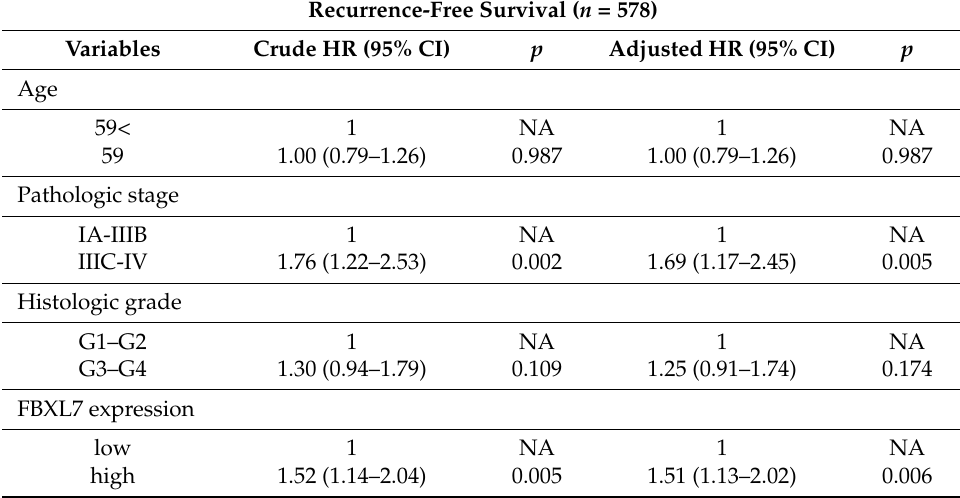
Table 1. Cox univariate and multivariate analyses under the condition of recurrence-free survival probability in association with FBXL7 mRNA expression levels and pathological stage derived TCGA (The Cancer Genome Atlas) cohort with ovarian serous